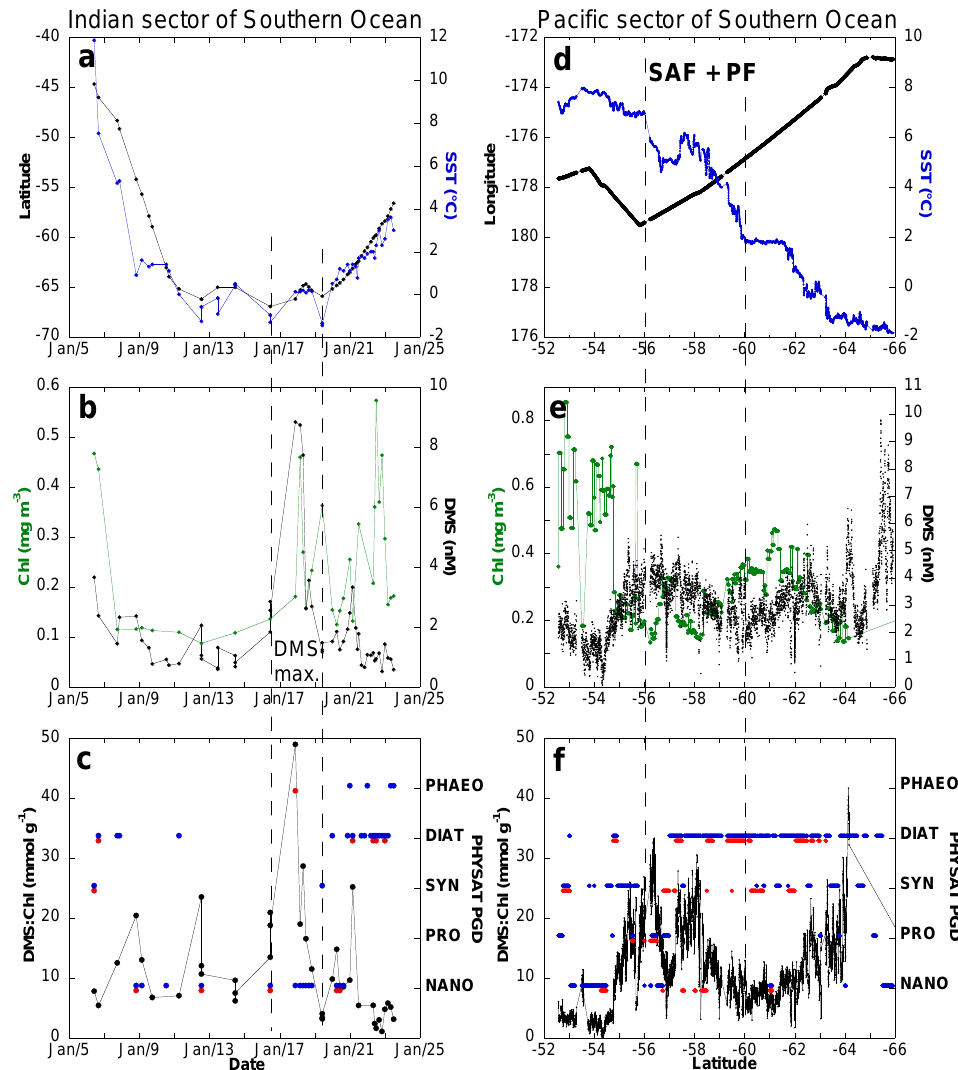
Fig. 6. Spatial and temporal distributions of the following parameters in the Indian (left panels) and Pacific (right panels) sectors of the Southern Ocean: (a, d) sea surface temperature (SST: ◦ C, in blue) and latitude/longitude (in black), (b, e) ocean color (Chl: mgm − 3 , in green) and sea surface dimethylsulfide concentration (DMS: nM, in black), (c, f) DMS-to-Chl ratio (DMS:Chl, mmolg − 1 , in black) and monthly (red dots) and monthly climatological (blue dots) composites of phytoplankton group dominance. SO: Southern Ocean, SAF: subantarctic front, PF: polar